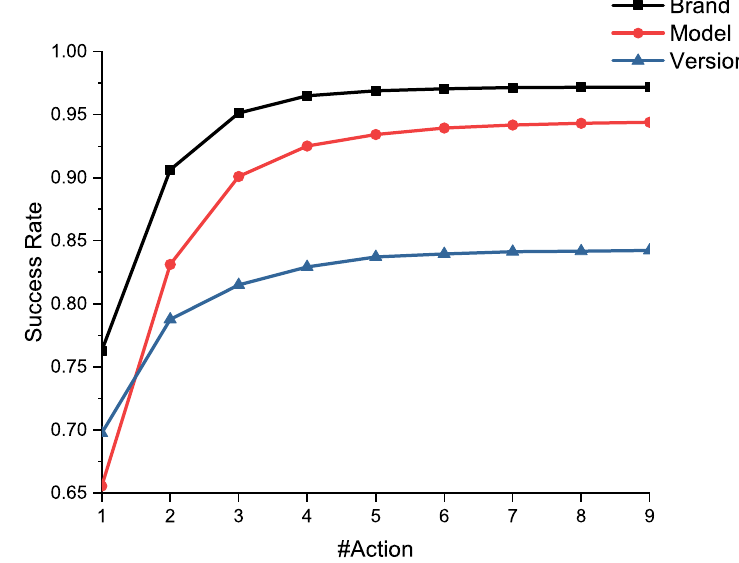
Figure 6. The success rate of device fingerprint